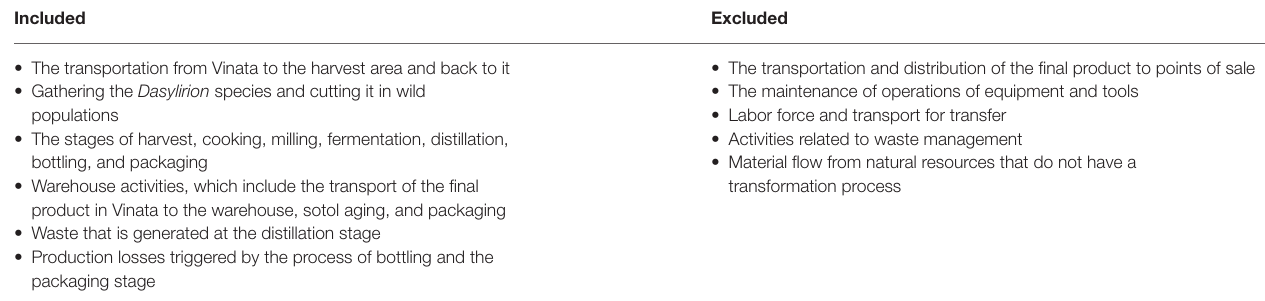
TABLE 1 | Data included and excluded for sotol life cycle assessment.